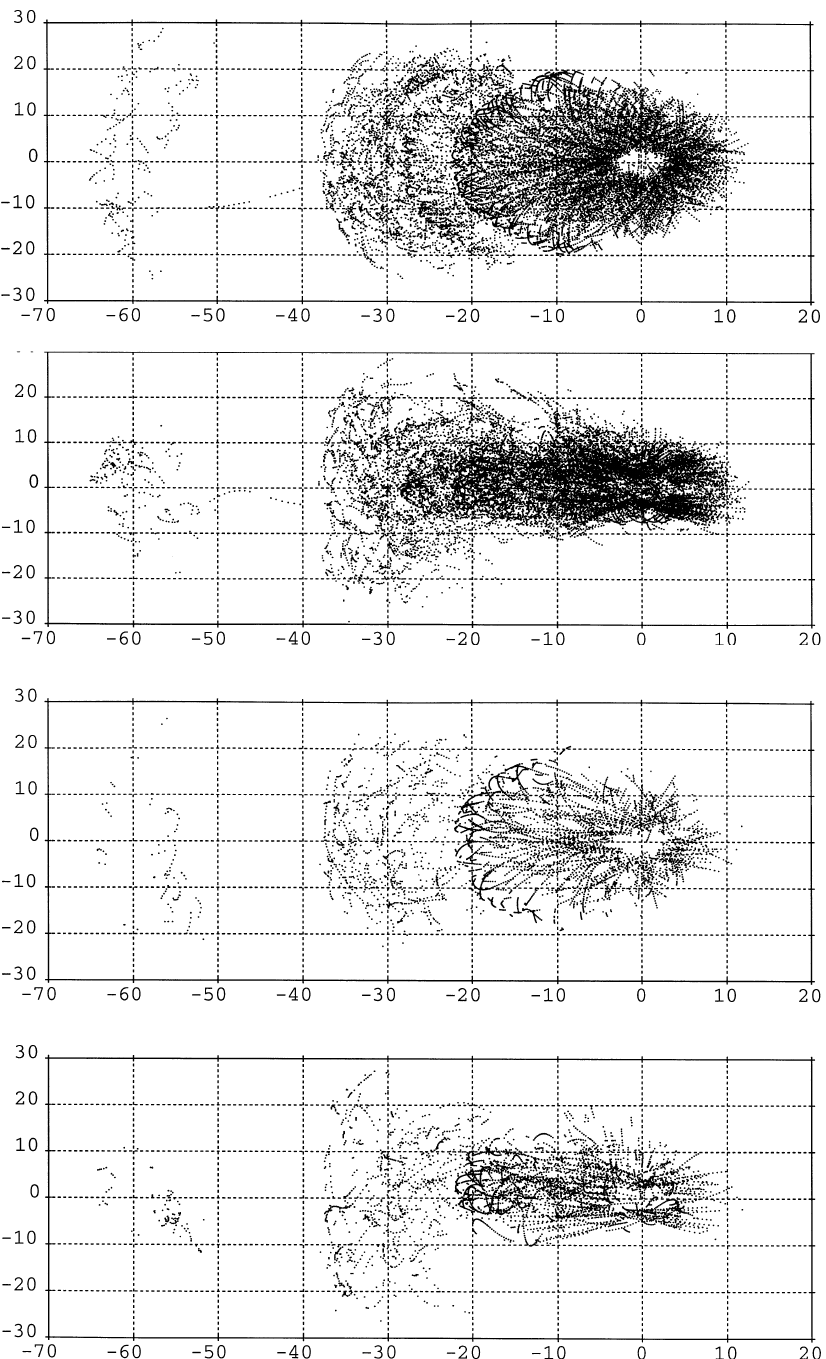
Fig. 2. In these two plots the location of the data points for a low geomagnetic activity level (Kp = 1) are displayed in the solar magnetospheric coordinate system planes xgsm - ygsm and xgsm - zgsm . Notice the ab- sence of points near xgsm (cid:136) 0 and for zgsm values greater than 14 Re or below (cid:255) 10 Re. Notice also the lack of points for distances less than